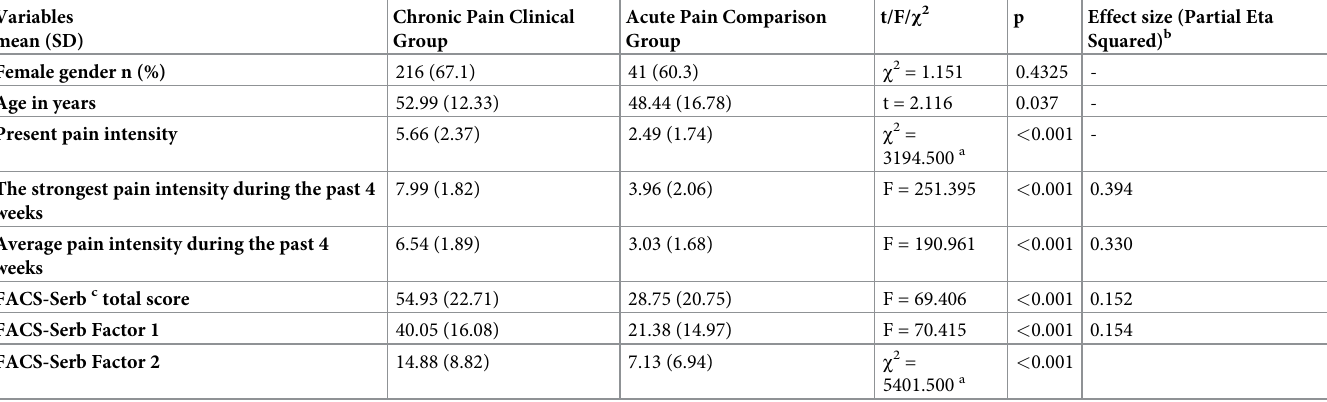
Table 4. FACS-Serb score comparison between the chronic pain clinical sample (N = 322) and the acute pain control sample (N = 68).